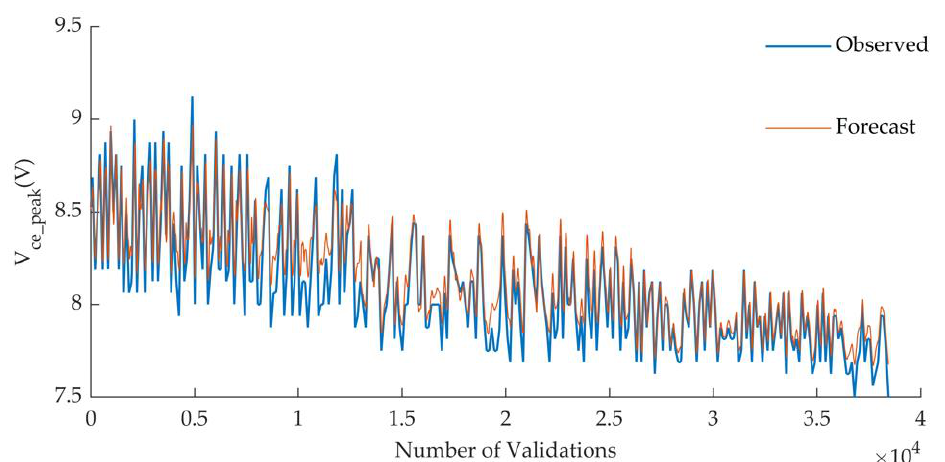
Figure 7. The third LSTM prediction.